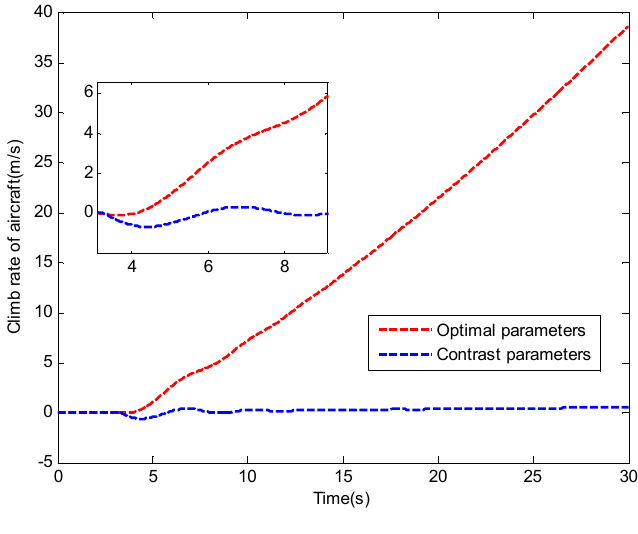
Figure 10. Climb rate of aircraft.